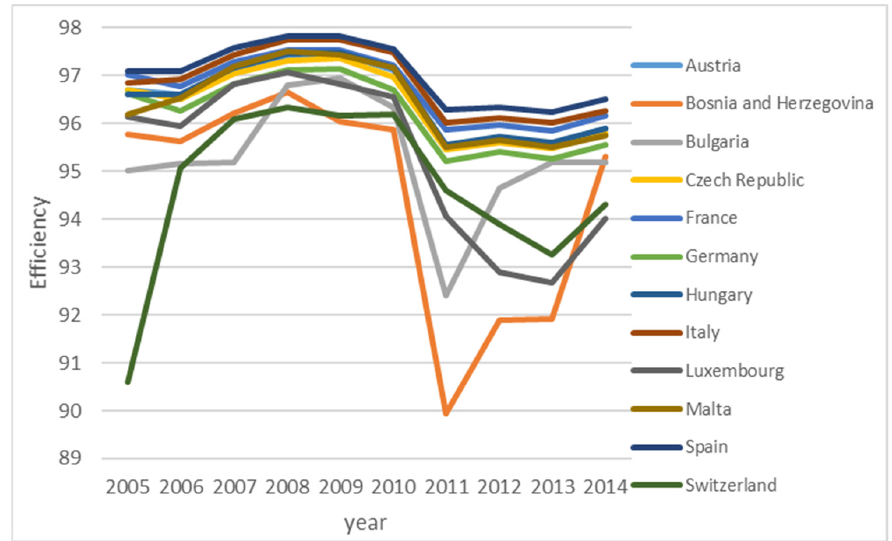
Figure 6. Countries with S shape efficiency.